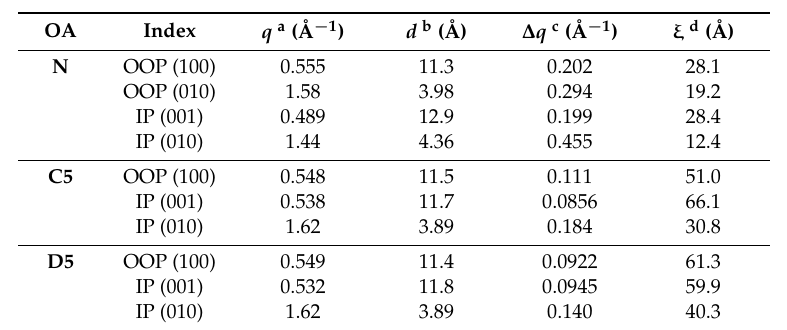
Table 3. Grazing-incidence wide-angle X-ray scattering (GIWAXS) diffraction peak analysis of